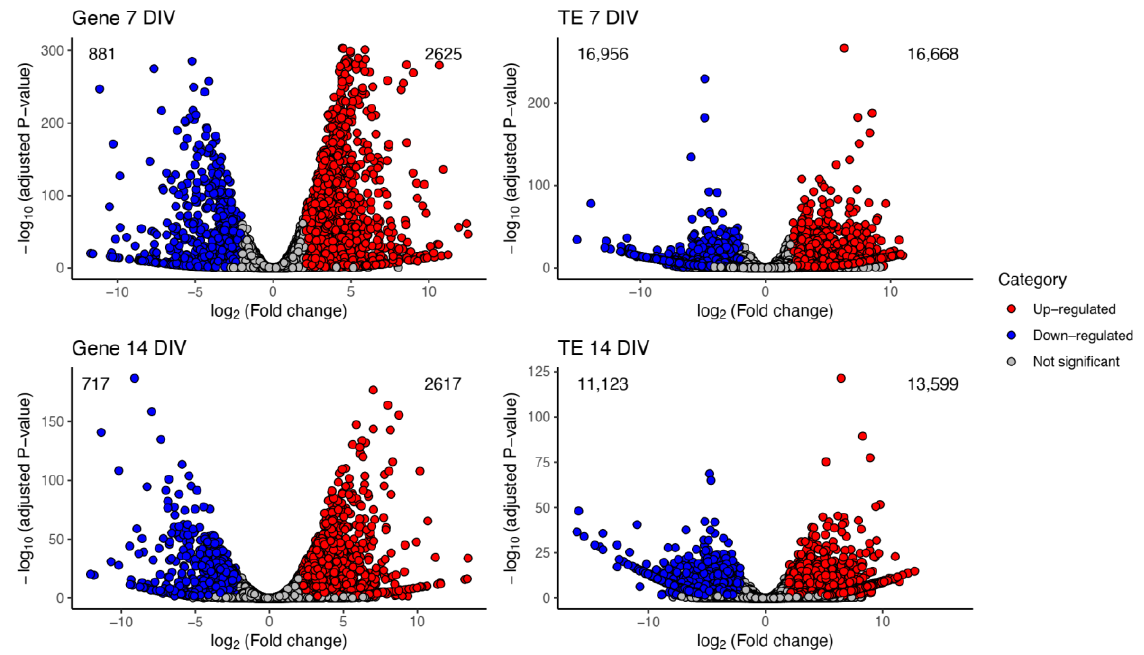
Figure 2. Differential expression of genes and TEs in iMNs TDP-43 WT and TDP-43 M337V . Volcano plots showing all genes ( left ) and TEs ( right ) differentially expressed (DE) at 7 DIV ( top panel) and 14 DIV ( lower panel). Up-regulated and down-regulated genes and TEs are shown in red and blue circles; gray circles represent genes and TEs that did not meet the overall expression threshold (| log 2 (fold change) |≥ 2; adjusted p - value ≤ 0.05; see Methods).